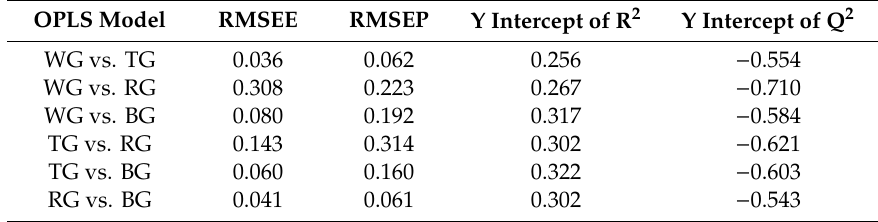
Table 2. The results of OPLS model validation. RMSEE, the root mean square error of estimation; RMSEP, the root mean square error of